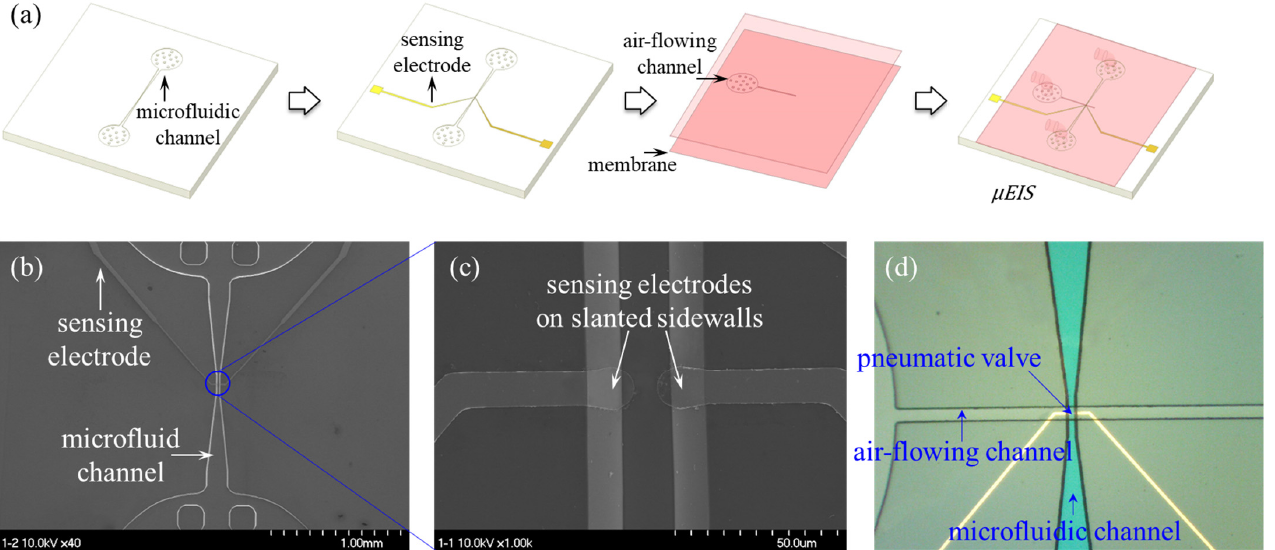
Figure 4. Fabrication of the µ EIS device. ( a ) Schematics of fabrication flow. SEM images of ( b ) mi-crofluidic channel integrated with sensing electrodes and ( c ) sensing electrodes on slanted sidewalls. ( d ) Optical microscopy image of the fabricated μ EIS device.